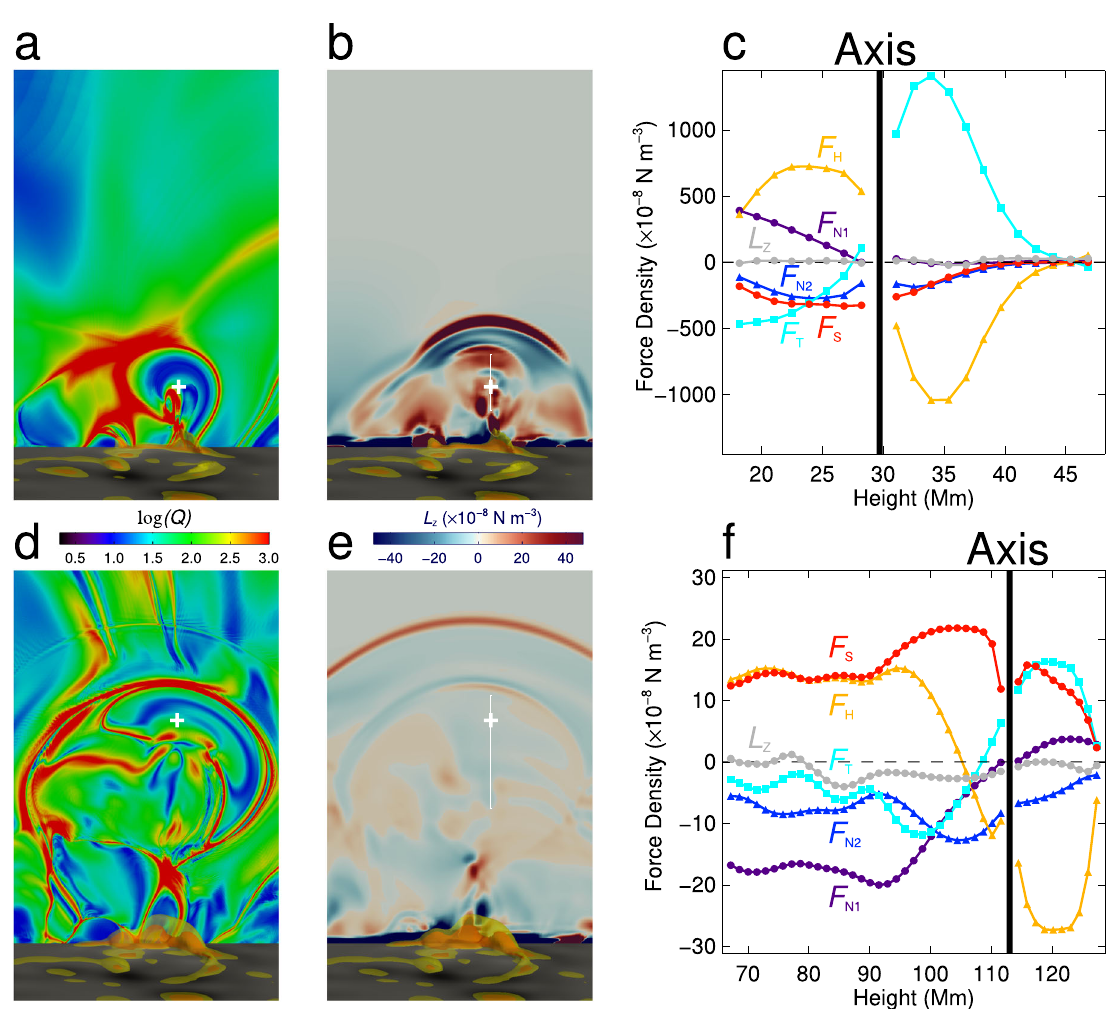
Fig. 7 Comparison between the QSLs and the Lorentz force, L z . The upper panels are for the time of 00:16 UT and the lower panels for the time of 02:00 UT, which represent the early phase and the later phase of the eruption, respectively. a Distribution of the QSLs in the Y – Z plane at the time of 00:16 UT. The QSLs show the boundary of the MFR. The white plus symbol refers to the axis of the fl ux rope. The background at the bottom of the fi gure shows the distribution of the vertical magnetic fi eld component, B z . The yellow and orange semi-transparent isosurfaces represent the electric current density larger than 21.9% and 32.9% of the maximum value in the whole domain, respectively. b Distribution of the Lorentz force in the Y – Z plane at the time of 00:16 UT. The white plus symbol has the same meaning as that in a . The white vertical line has a length of 31.5 Mm (covering a height range from 16.8 to 48.3 Mm), which extends from the bottom to the top of the MFR. The background is the same as that in a . c Distribution of the vertical component of the Lorentz force, L z , along the white line in panel b . The gray line is for the net force. The orange, purple, blue, red, and cyan lines represent the different components including the hoop force ( F H ), non-axisymmetry induced forces ( F N1 and F N2 ), strapping force ( F S ) and tension force ( F T ), which are listed in Supplementary Table 1. The black vertical line shows the location of the axis of the MFR. d Similar to panel a but at the time of 02:00 UT. e Similar to panel b but at the time of 02:00 UT. The white vertical line has a length of 63.0 Mm (covering a height range from 65.8 to 128.8 Mm). f Similar to panel c but at the time of 02:00